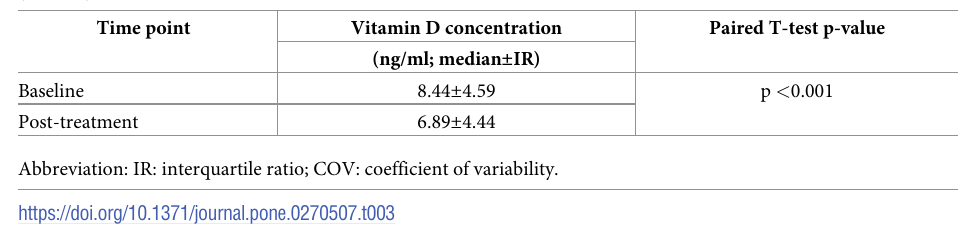
Table 3. Vitamin D concentration changes between baseline and post-chemotherapy in breast cancer patients (n = 136).